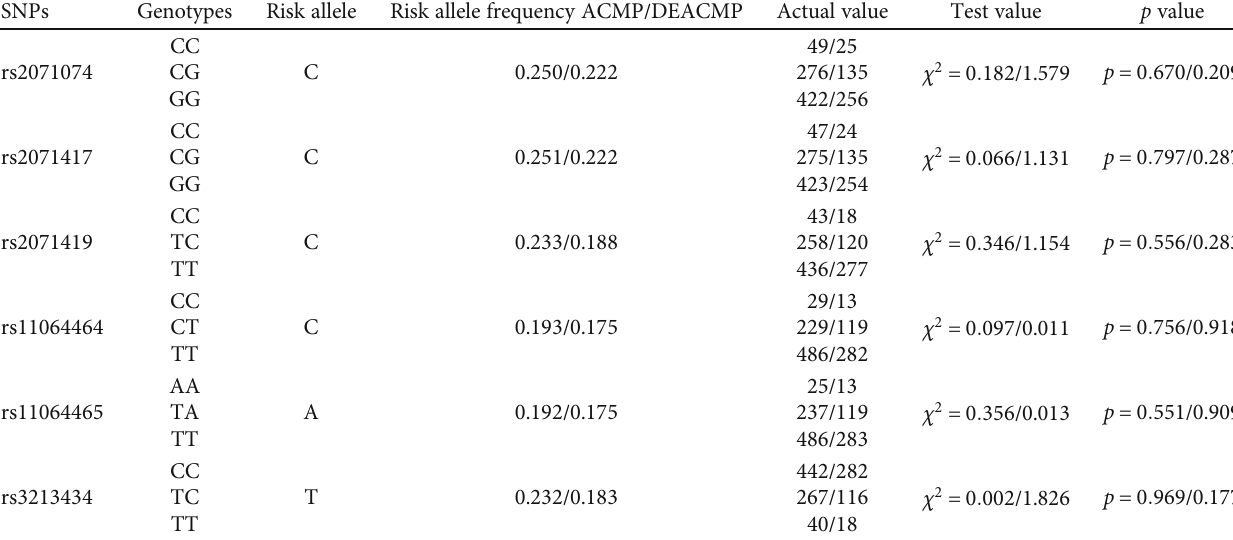
Table 3: Results of Hardy-Weinberg equilibrium test for genotype distributions of